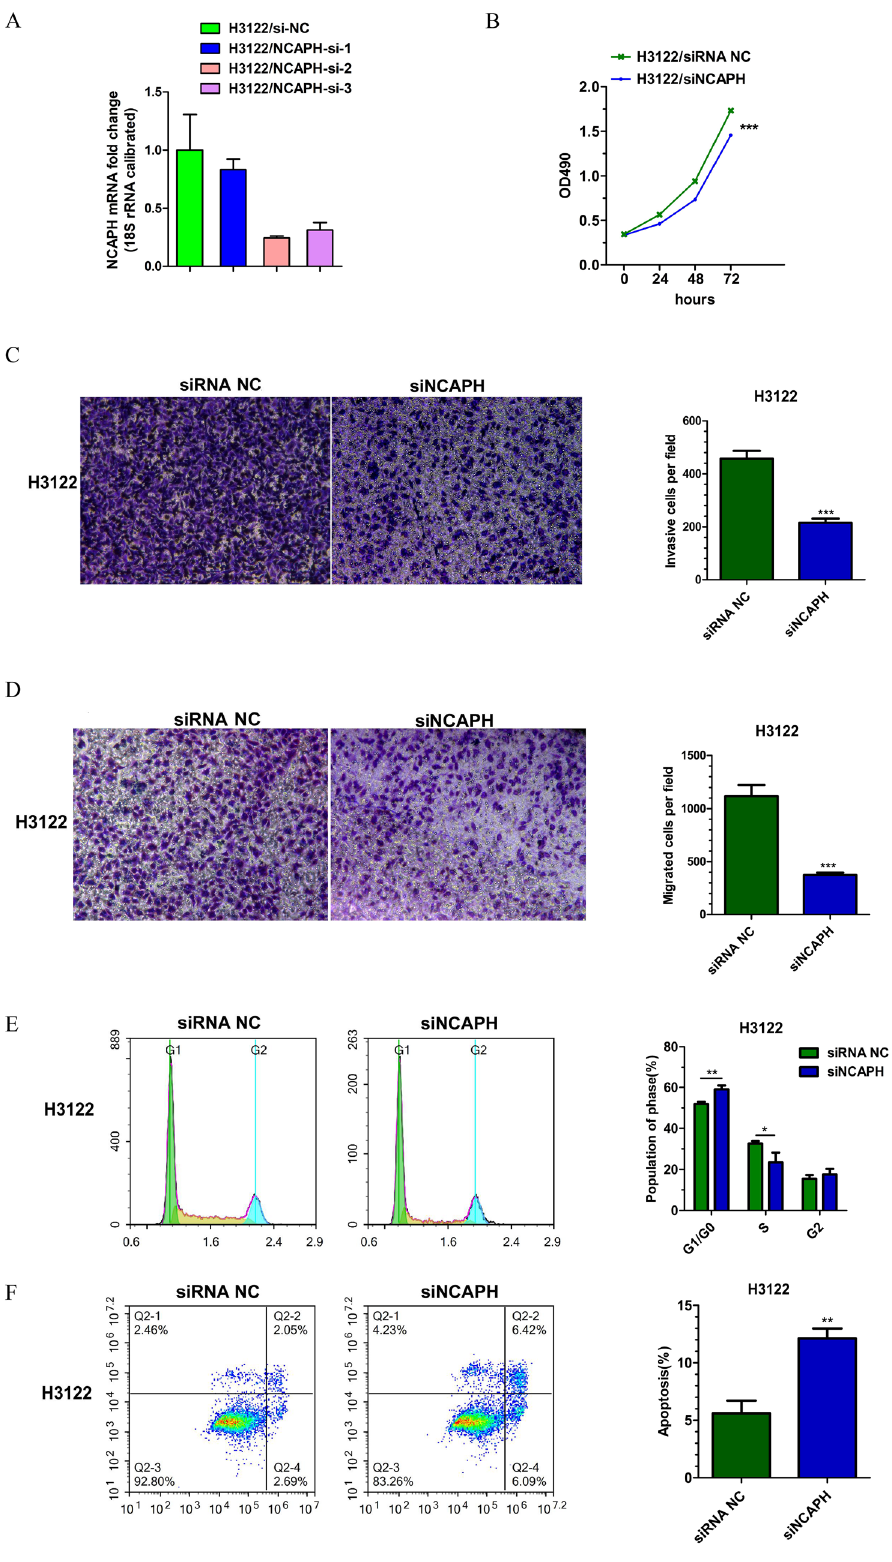
Figure 8. Knockdown of NCAPH by siRNA treatment regulate proliferation, migration, invasion, cell cycle and apoptosis of LUAD cells in H3122: ( A ) Knockdown efficiency of three different siRNAs for NCAPH; ( B ) MTT assay for cell proliferation; ( C ) Migration assay; ( D ) Invasion assay; ( E ) Cell cycle image and data; ( F ) Apoptosis assay.* P < 0.05,** P < 0.01,*** P <